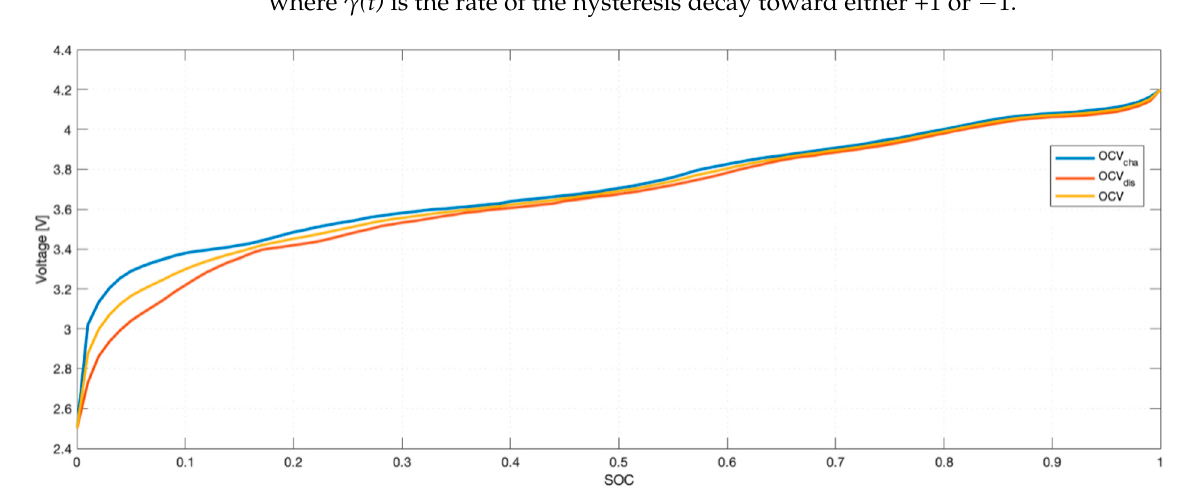
Figure 2. EECM of the Li ‐ ion cell.